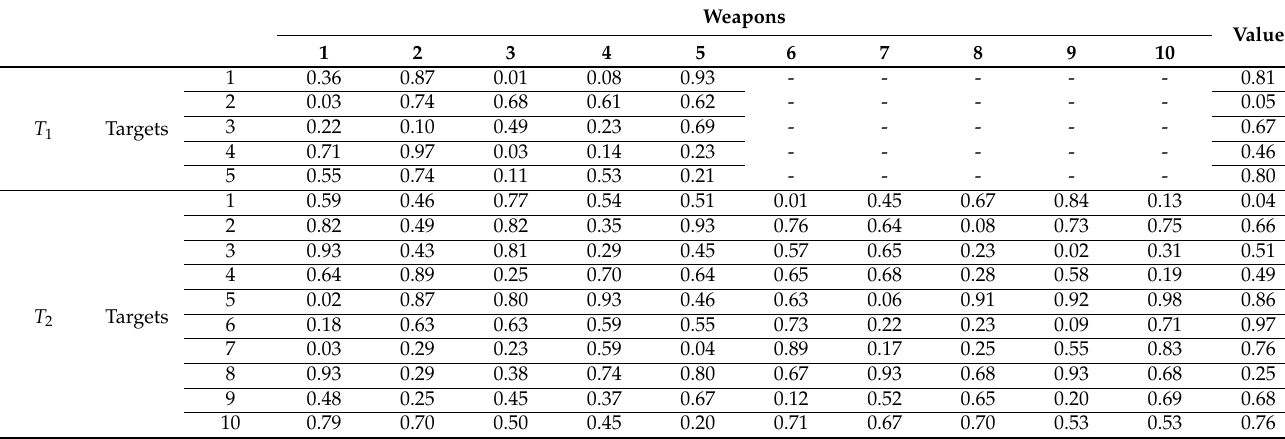
Table A3. Details of the destructive value of every target and the probability of kill for every weapon in the two component tasks of problem 4 in Table 2. Each task is a WTA problem.